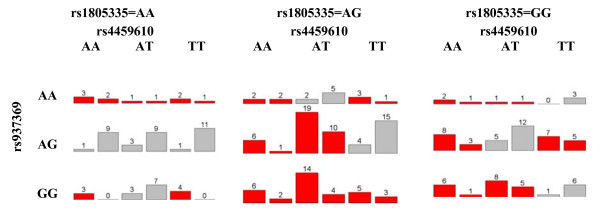
The case-control distribution for MDR. The case-control distribution of the finally selected 3-way interaction model for MDR. If a person falls in the red cell, MDR classifies him as a case(AR), otherwise a control.